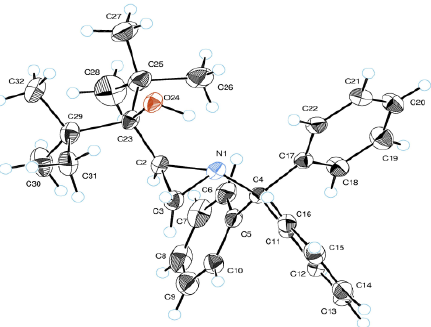
Figure 1. Crystal X-ray structure of carbinol 6c .